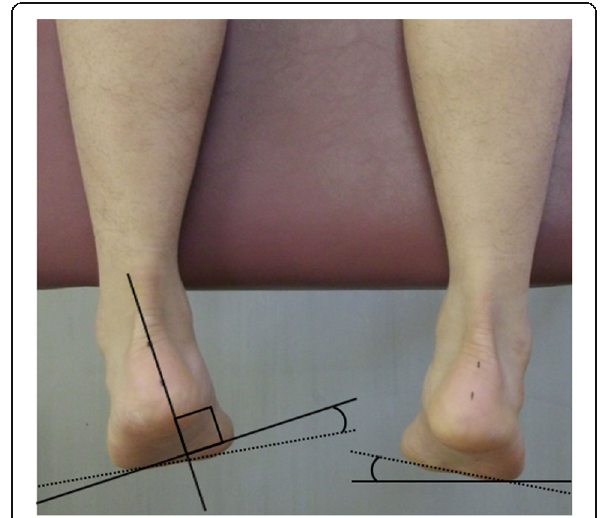
Fig. 3 Left : measurement of FA-R. Right : measurement of FA-H. FA-R: the angle between a line perpendicular to the calcaneal bone axis and a line from the thenar to the hypothenar. FA-H: the angle between the horizontal axis and a line from the thenar to the hypothenar leg and Achilles tendon. Subjects were placed in the weight-bearing position (standing) and non-weight- bearing position (prone) with the hips, knees, and ankles neutral, and photographs were taken from the posterior of the feet (Figs. 1 and 2). A photograph was also taken of all participants ’ lower legs and calcanei from the pos- terior side. Then, we measured the angle between the lower leg line and calcaneus line using image analysis software (ImageJ; US National Institutes of Health, Bethesda, MD, USA).